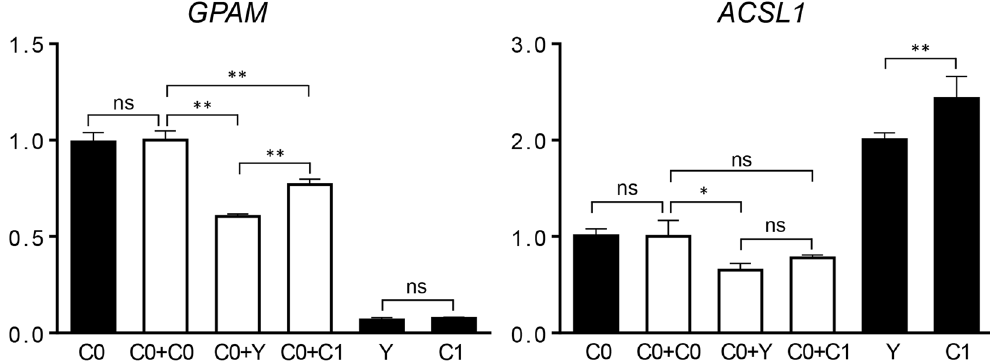
Figure 5. Expression levels of two fat synthesis related genes. Black columns, primary cells; white columns, cybrid cells. Bars indicate the standard deviation (SD), n = 3 per group. * P < 0.05, ** P < 0.01 and ns P >